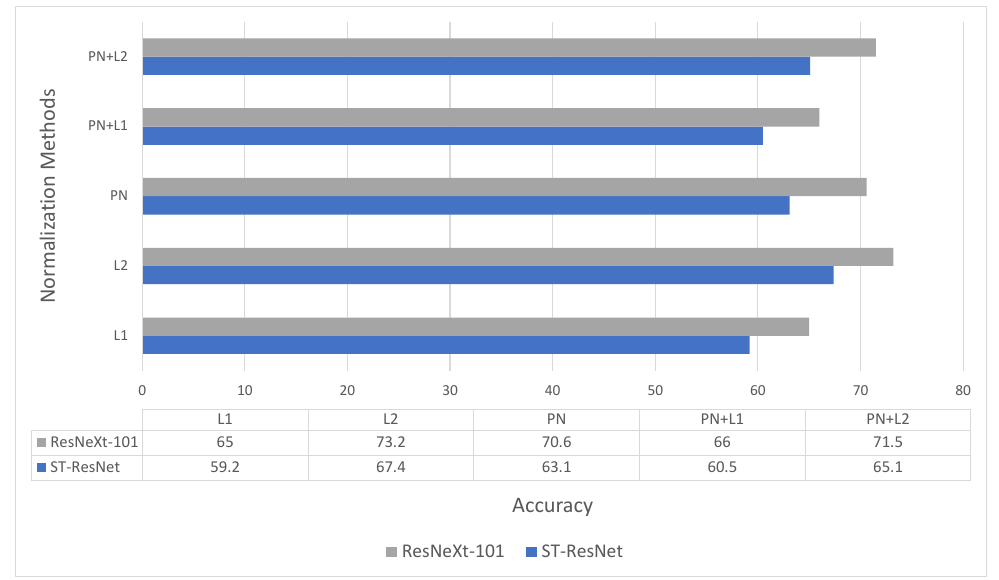
Figure 5. Impact on accuracy by varying the codebook size.